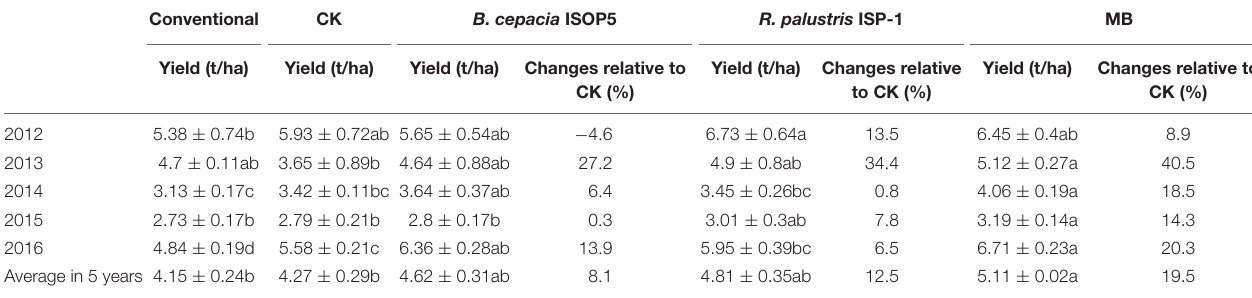
TABLE 1 | Peanut yield for five consecutive years and yield increase rates with bacterial inoculum treatments compared with CK treatment. Conventional